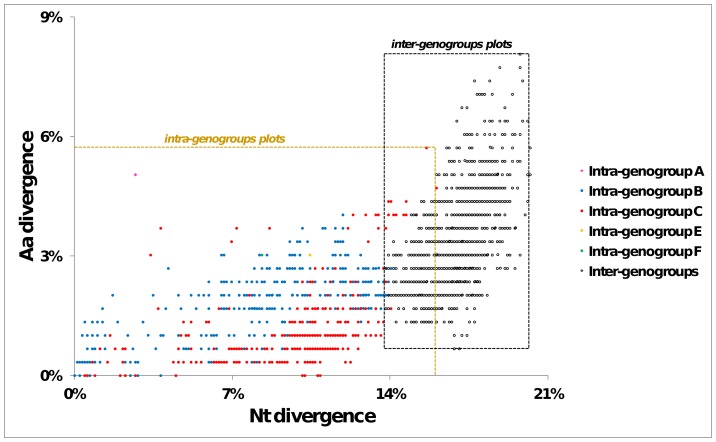
Molecular differentiation of the EV-A71 genogroups.The percentages of nucleotide and amino acid divergences were calculated in pairwise comparisons of 59 sequences selected as representative of the EV-A71 genogroups and subgenogroups. A scatter plot was produced with the divergence values to determine a threshold between intra-and inter-genogroup differences.